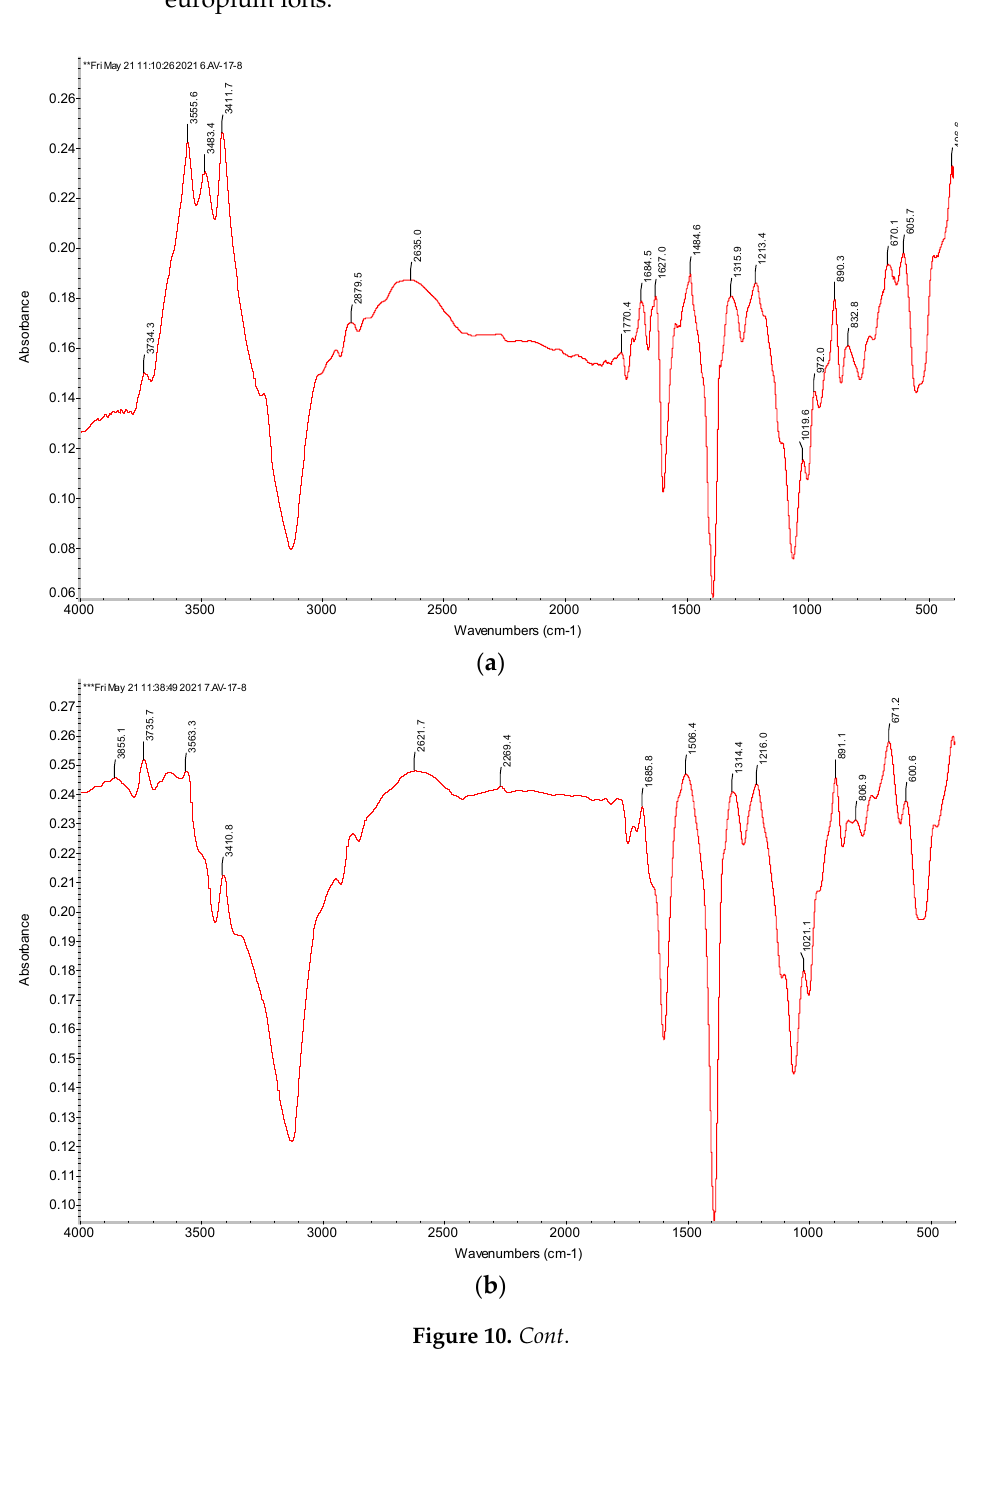
Figure 9. Fourier transform infrared (FTIR) spectra of ( a ) Amberlite IR120; ( b ) Amberlite IR120 6:0; ( c ) Amberlite IR120 1:5.